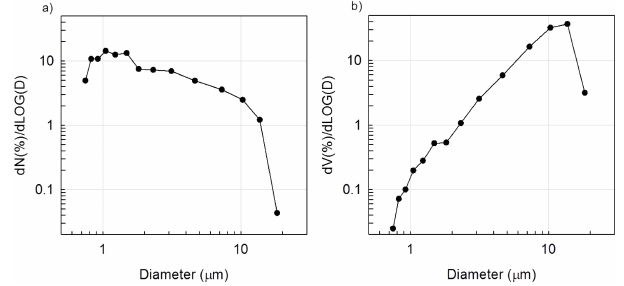
Figure 1. Relative (percent of total) (a) number and (b) volume dis- tributions of powdered salt delivered to the CAS sampling volume from the